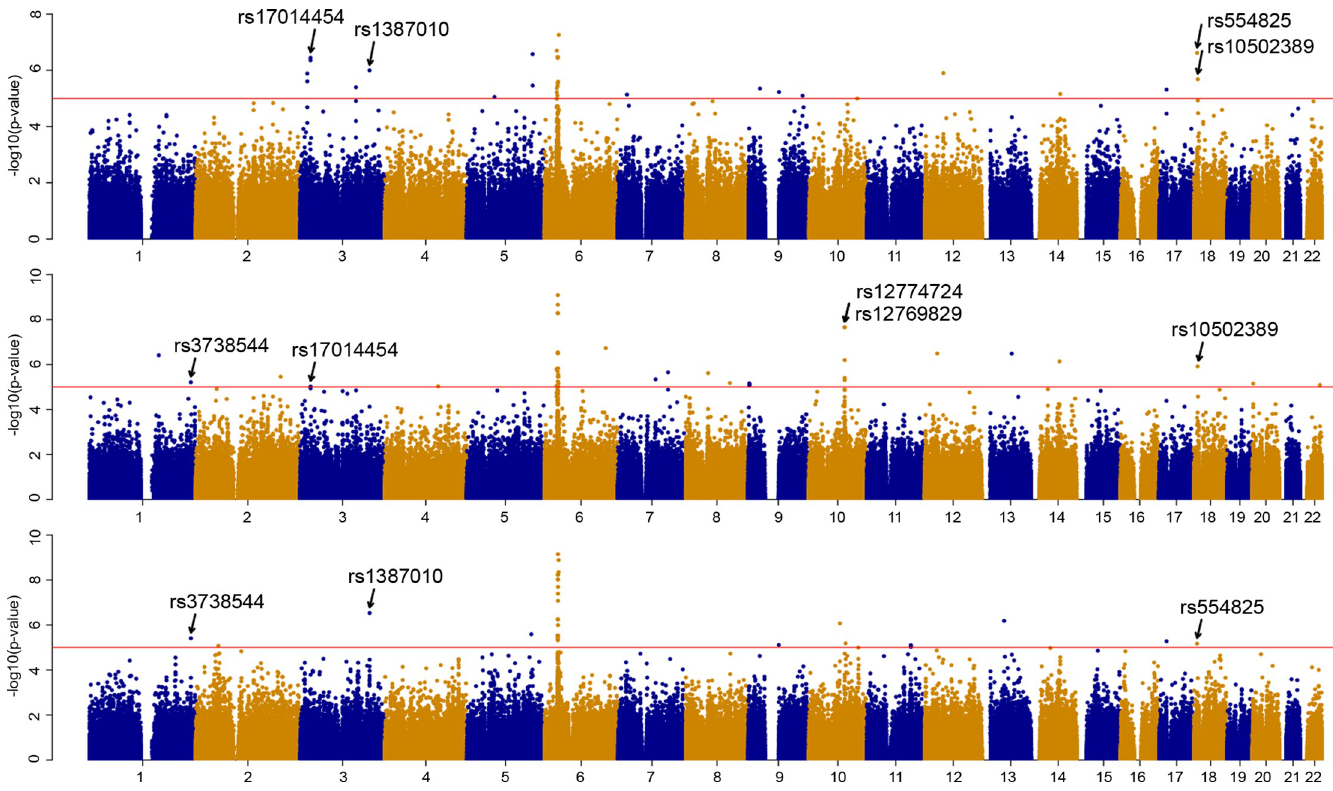
Fig 2. Genome-wide (autosomes 1–22) distribution of p-values for iHS scores in three out of the eight populations studied. The populations are (from top to bottom): Russians from Mezen, Russians from Ustyuzhna, and Veps. Horizontal red lines indicate P-value threshold applied ( P � 1 × 10 − 5 ). Loci of interest are pointed with arrows.